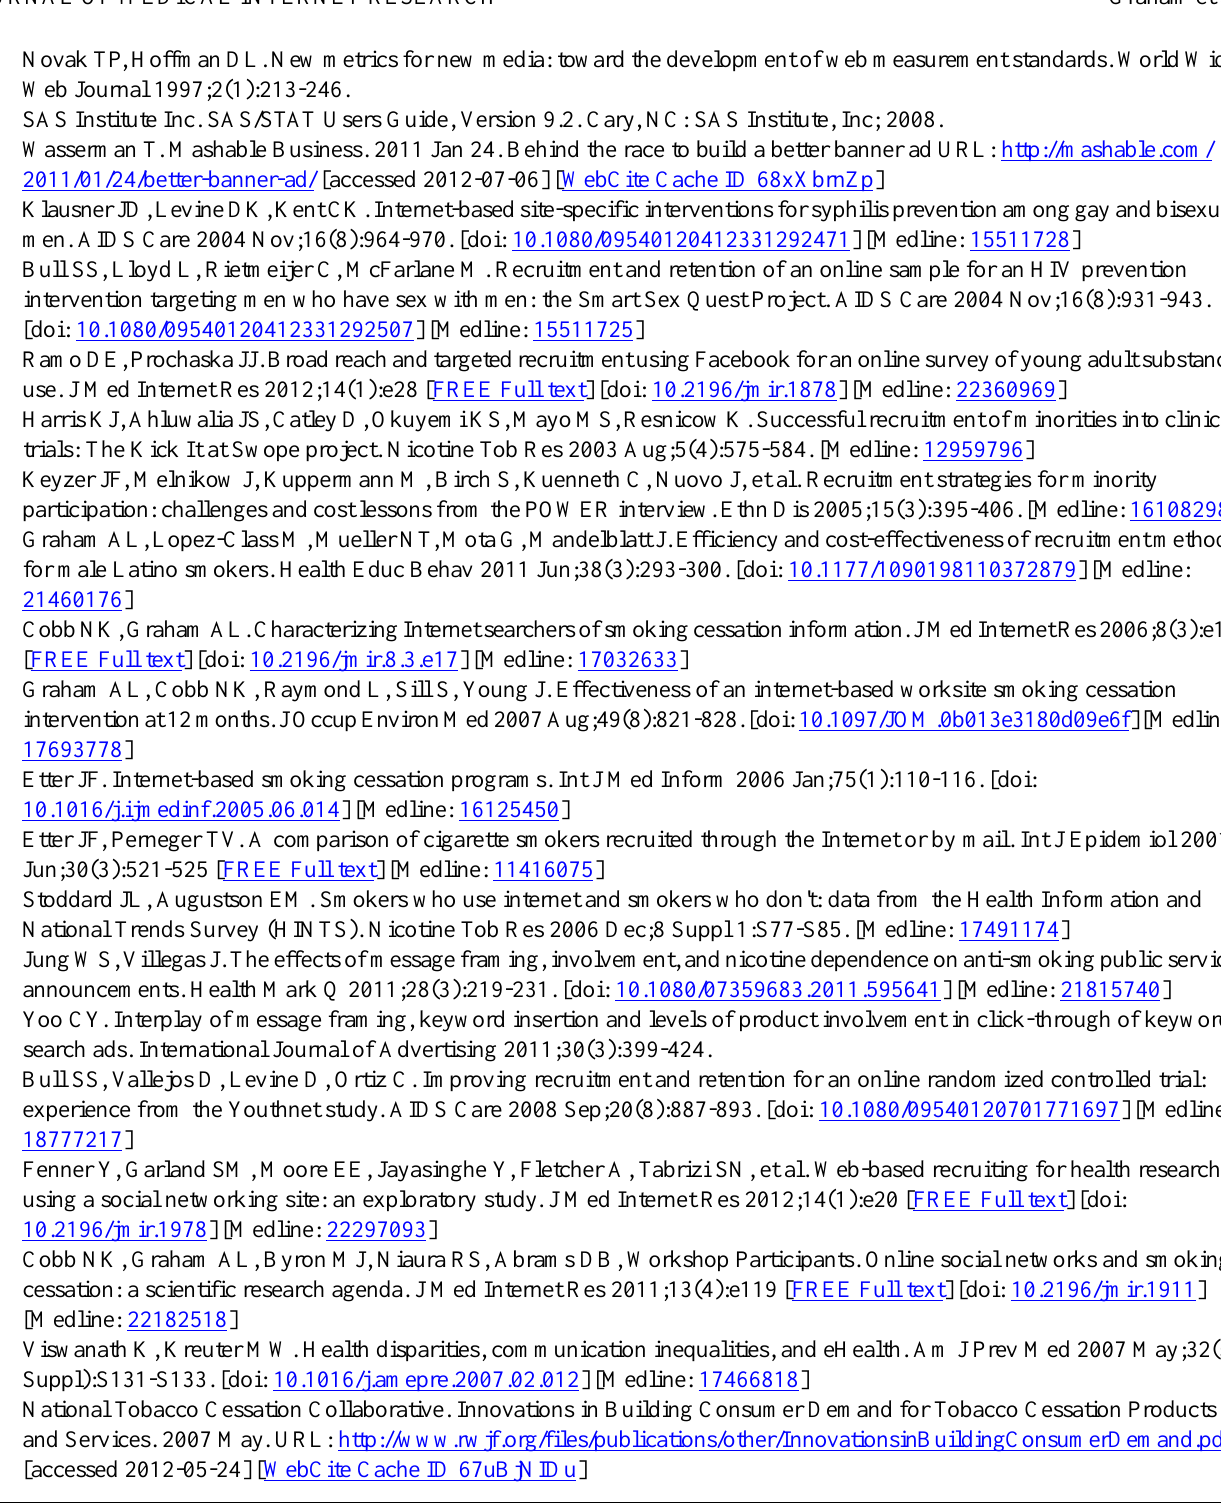
Abbreviations ANOVA: Analysis of variance SASH: Short Acculturation Scale for Hispanics